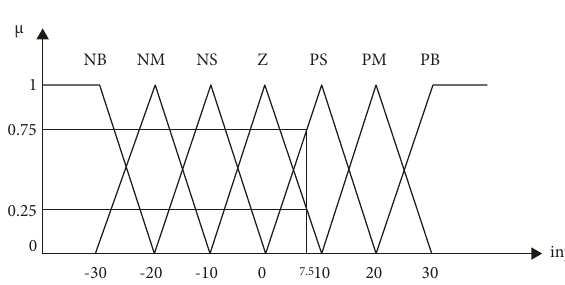
Figure 5: Fuzzy logic analysis of the